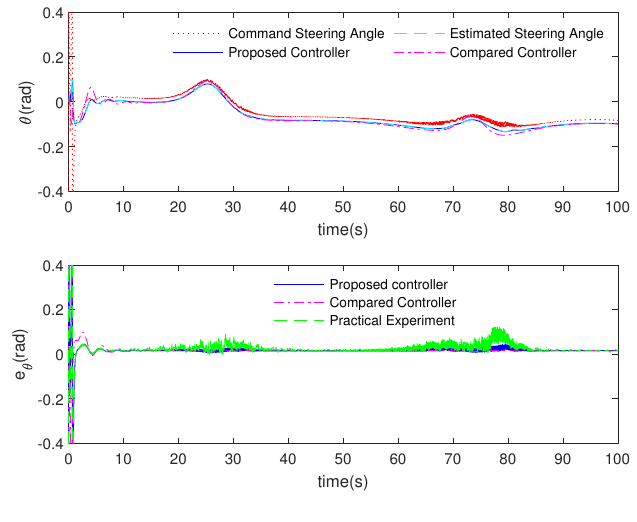
Figure 6. Steering angle.